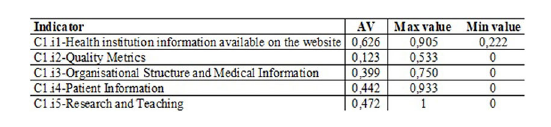
FIGURE3 Average value (AV), maximum value (Max value), and minimum value (Min value) obtained by each indicator composing criterion Content